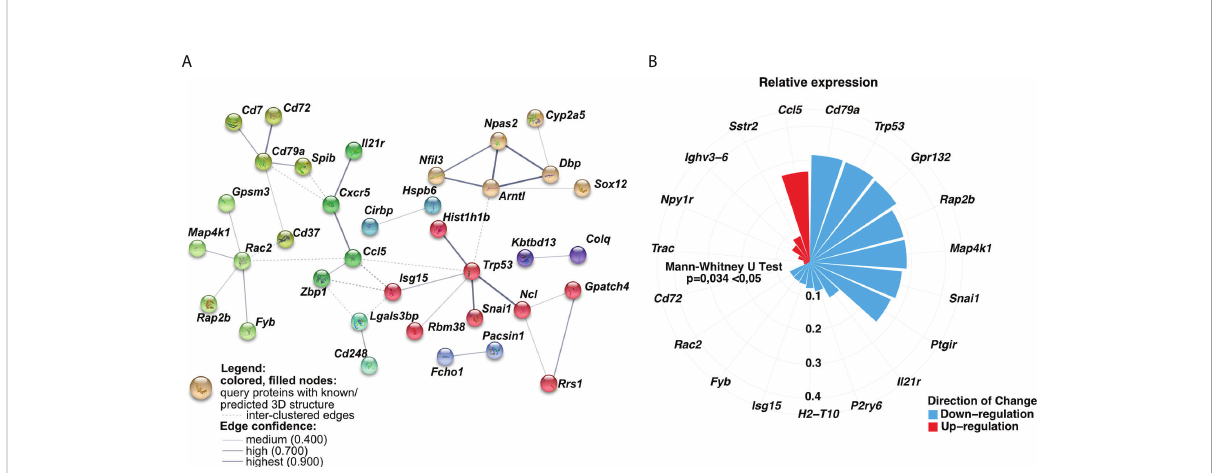
FIGURE 5 The relative expression of analyzed common genes changed longitudinally. (A) Genes-genes interaction networks corresponding to protein products were created using the String database. Nodes marked with the same color represent gene clusters. Solid lines show the connections within the individual cluster, whereas dashed lines refer to the interactions among the nodes. The line weight signi fi es the con fi dence of the relationship. (B) Circular bar plot indicated delta of genes expression with the altered z-scores at the time according to Ingenuity Pathway Analysis (IPA). The delta was obtained by subtraction between the expression of genes in the long-term and short-term models. The size and color of the bars represent the magnitude and the direction of change, respectively. A two-tailed Mann U Whitney test was performed to assess the statistical signi fi